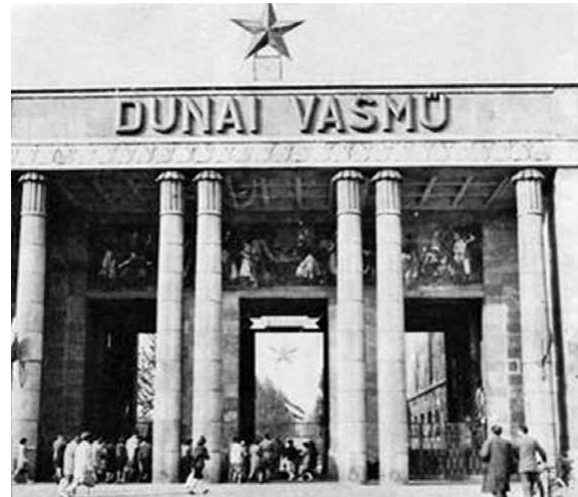
fig. 2. Main entrance of the steelworks, a good example of the socialist-realist-style in